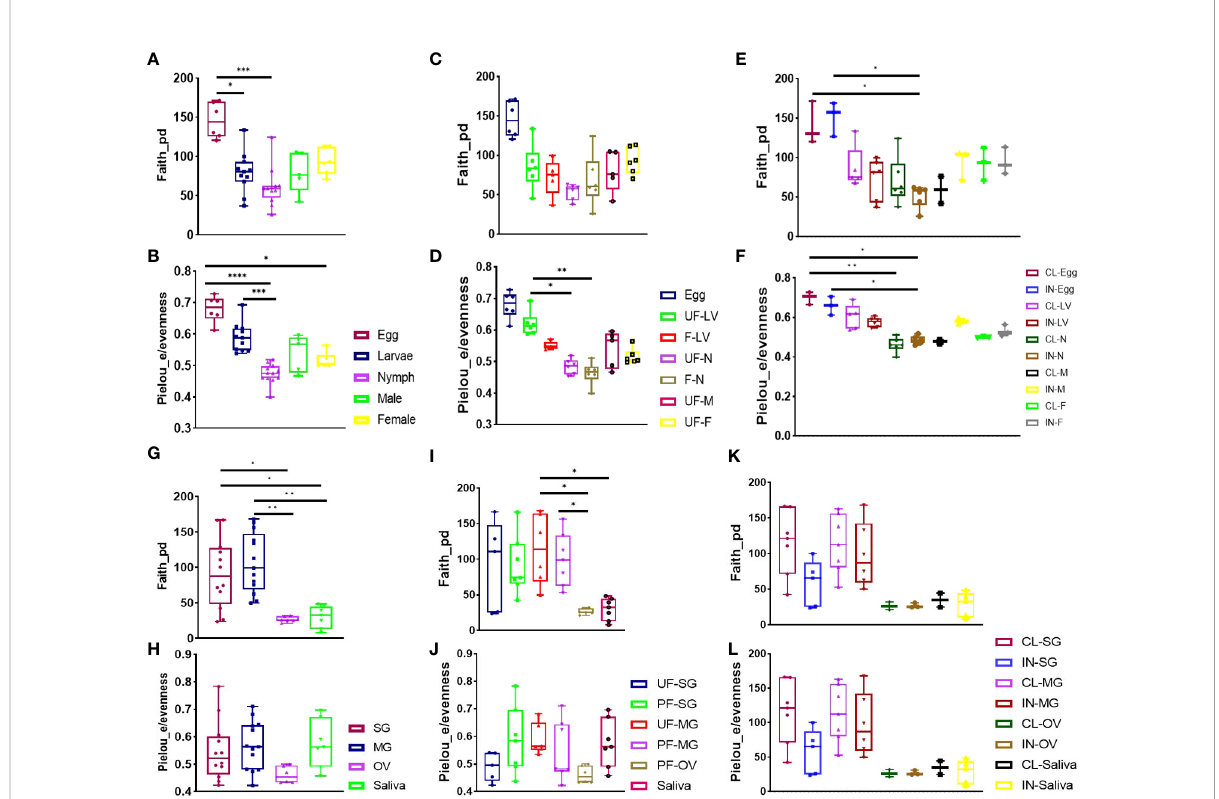
FIGURE 1 Alpha diversity of microbial richness across all developmental stages and isolated tissues. Diversity analysis using Faith phylogenetic distance (species richness) and Pielou_e metrics (evenness) in (A, B) all developmental stages, (C, D) unfed and fully fed developmental stages, (E, F) R. parkeri -infected and uninfected developmental stages, (G, H) all tissues, (I, J) unfed and fully fed tissues, and (K, L) R. parkeri -infected and uninfected tissues. Each bar on the abundance plot represents average data from 3 – 5 individual replicates. Each point of the box plots represents average data from 3 – 5 individual replicates. Unfed (UF), fed (F), larvae (LV), nymph (N), male (M), female (F), clean (CL), infected (IN). Boxplot height indicates the upper and lower quartiles. Whiskers indicate the maximum and minimum values. The black horizontal line indicates the median. Asterisks denote signi fi cance (*P < 0.05, **P < 0.01, ***P < 0.001, ****P <